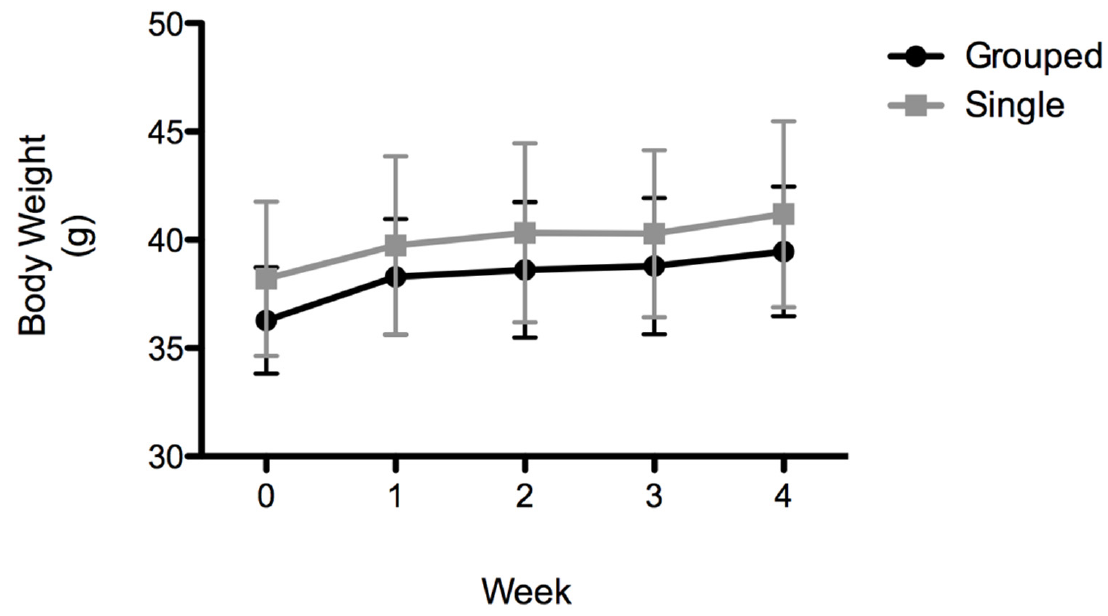
Figure 2. Body weight (g). Data are expressed as the mean ± SD; n = 8 per group.